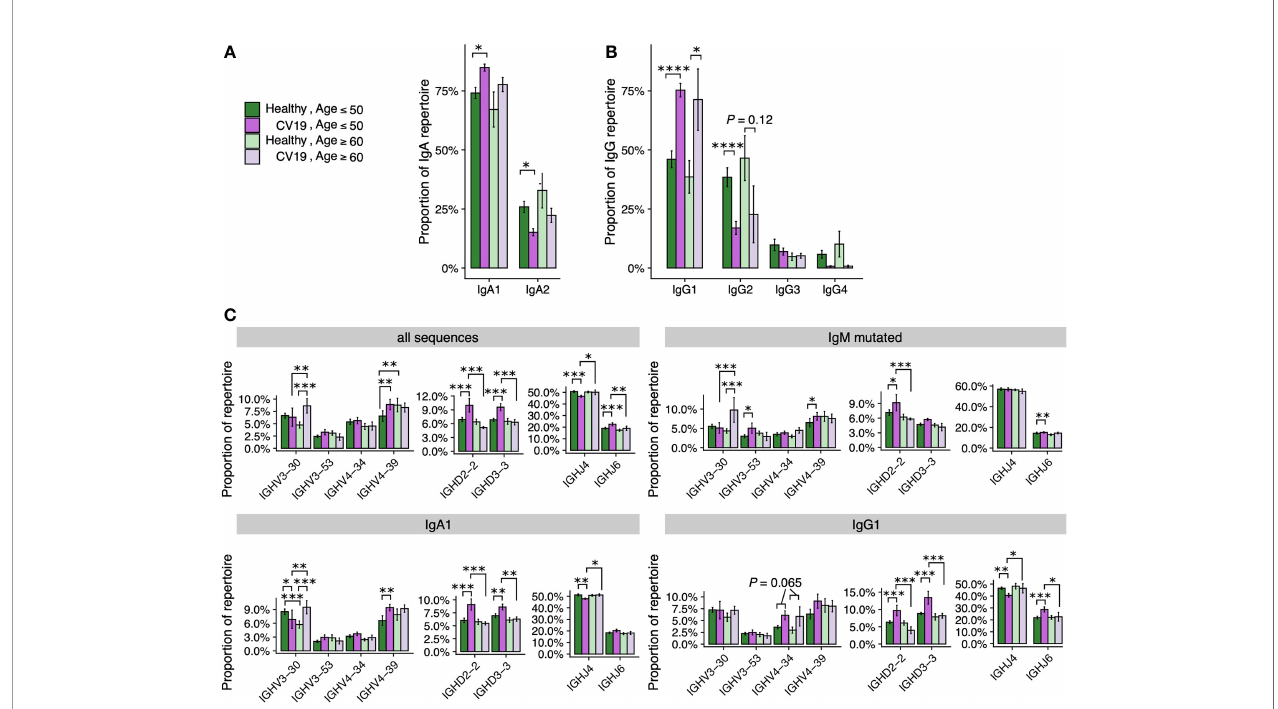
FIGURE 4 | V-D-J and isotype usage repertoire differences between healthy and CV19 are not as apparent in older ages. CV19 and healthy patients were split by over 60s and under 50s and were compared for IgA (A) , IgG (B) usage and selected V-D-J gene usage (C) . Statistical signi fi cance evaluated using two-way ANOVA and Tukey ’ s post-hoc test: *, false discovery rate (FDR, corrected using the Benjamini-Hochberg method) < 0.05; **, FDR < 0.01, ***, FDR < 0.001, ****, FDR <